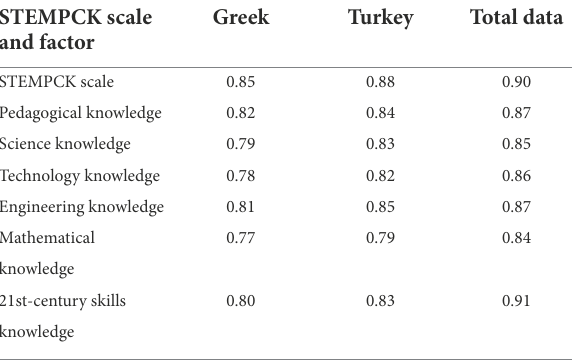
TABLE 4 Cronbach’s alpha values for STEMPCK scale and its component